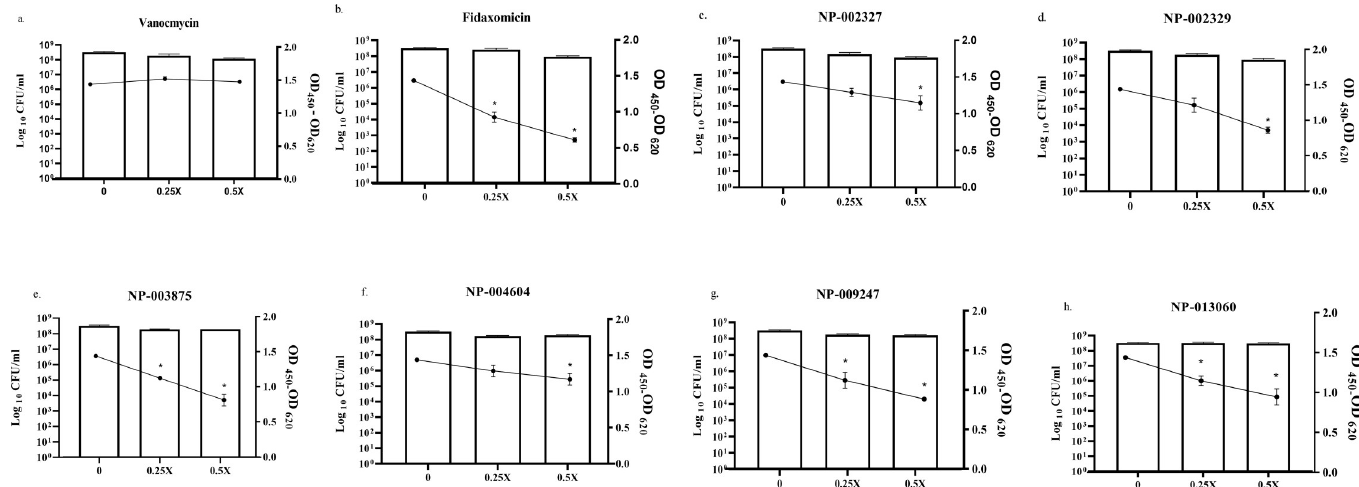
Fig 3. C . difficile toxin inhibition by natural products and control antibiotics (vancomycin and fidaxomicin). C . difficile was incubated with subinhibitory concentrations of drugs for 12 hours. Viable cells (log 10 CFU/ml, bars) in each sample were determined by plating and the amount of toxin in each supernatant (OD 450 - OD 620 , lines) was assessed using ELISA. The data represents the mean and standard deviation for triplicate samples of each treatment. Asterisk ( � ) indicates a statically significant difference in the toxin content of the supernatant between the fidaxomicin- or natural product-treated samples and the untreated control.